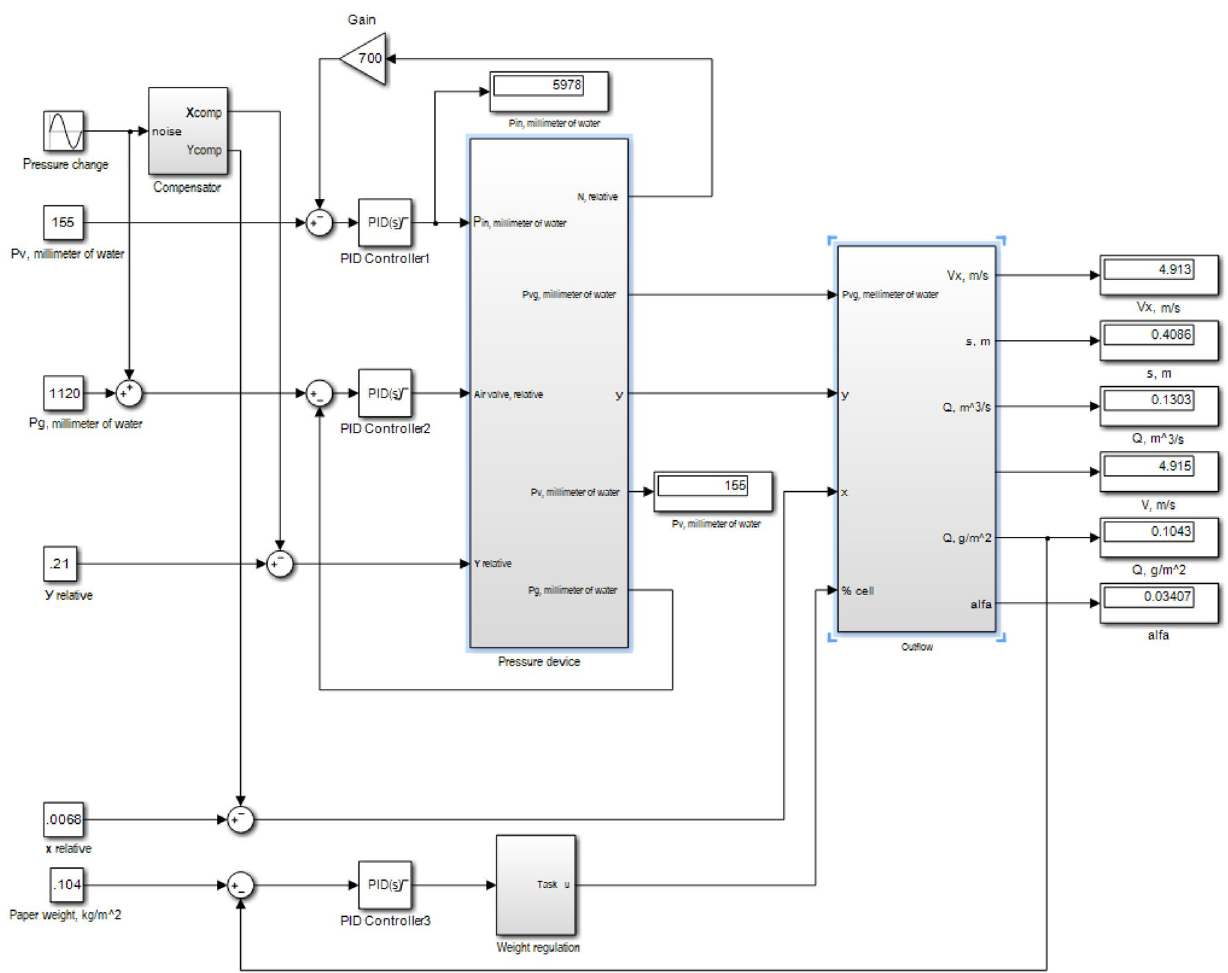
Fig. 9 Simulink model of parameter